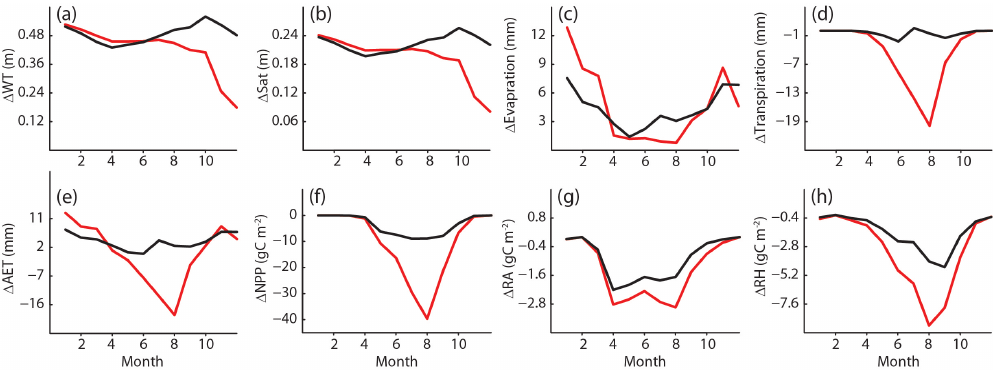
Fig. 7. Comparison of the simulated differences (with vs. without water routing) in monthly values of major hydro-ecological variables between the wet (solid black line) and dry (solid red line)